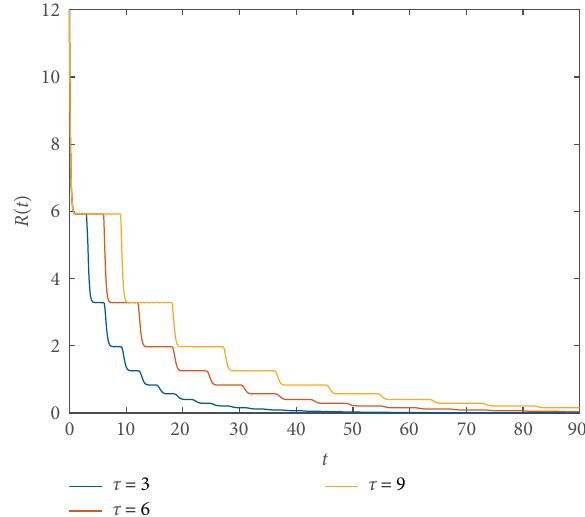
Figure 6: Asymptotic behavior of ̃휎 = 6, 훽 = 2,푅 0 = 12